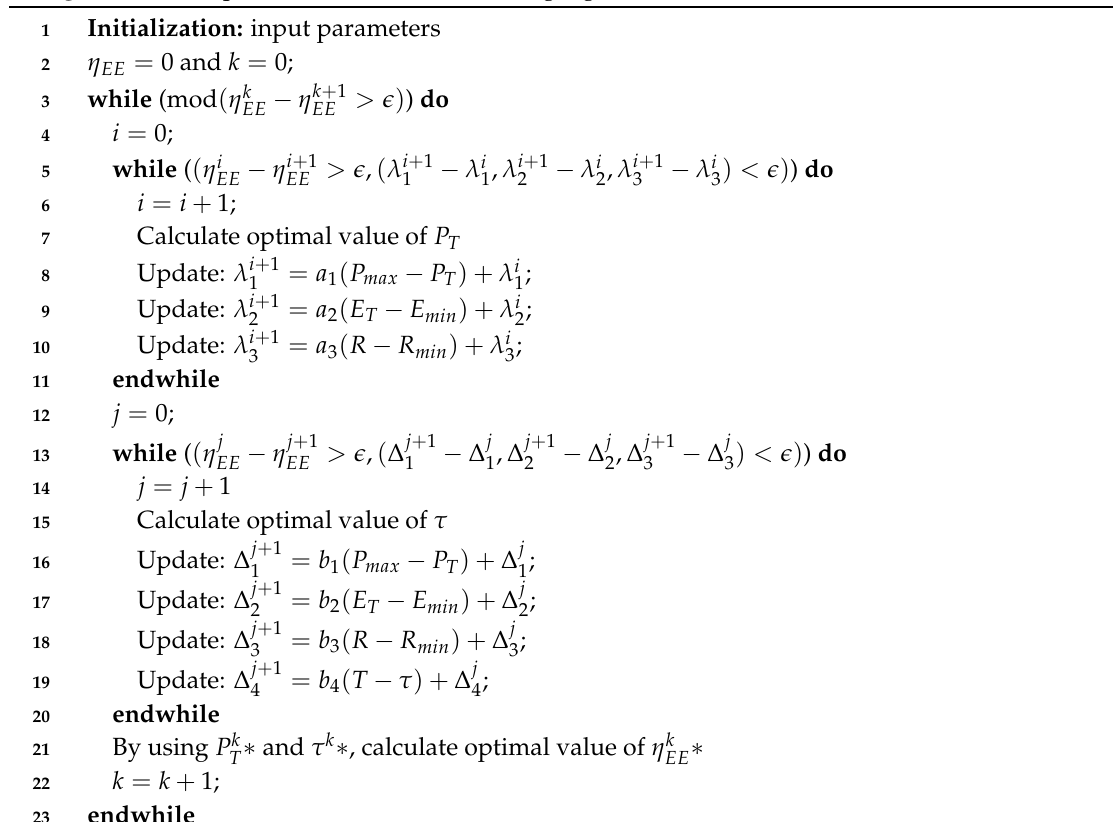
Algorithm 3: Proposed iterative time switching